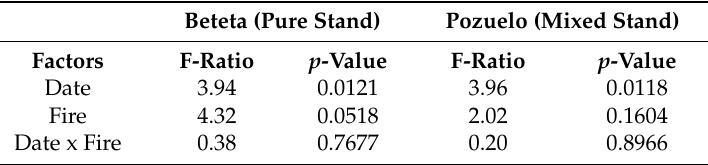
Table 4. Result of two-factor ANOVA (site and prescribed fire) for soil CO 2 efflux.